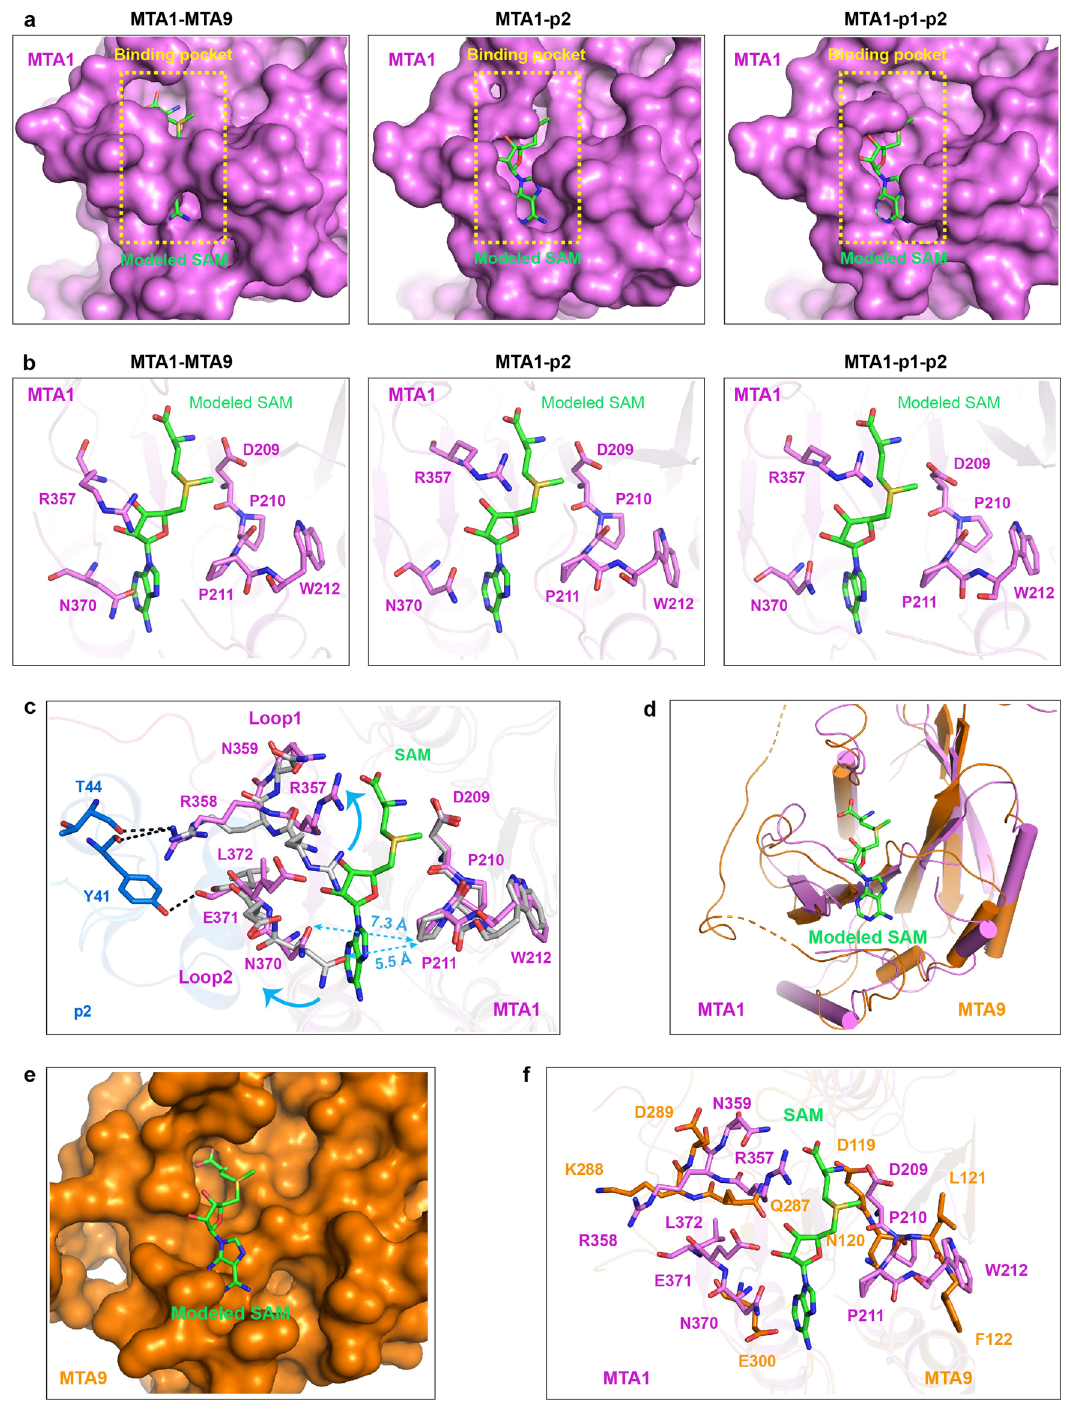
Fig. 6 Conformational change of MTA1 upon p2 binding. a Structural comparison of the SAM-binding pocket of MTA1 in the MTA1-MTA9 (left panel), MTA1-p2 (central panel) and MTA1-p1-p2 (right panel) complexes. Each MTA1 structure shows SAM-binding pocket in the SAM-free state. For comparison, a SAM molecule was modelled in the SAM-binding pocket of MTA1. b The SAM-binding pocket presents signi fi cantly different conformations in the structures of MTA1-MTA9 (left panel), MTA1-p2 (central panel) and MTA1-p1-p2 (right panel) complexes. Each MTA1 structure shows SAM- binding pocket in the SAM-free state. For comparison, a SAM molecule was modelled in the SAM-binding pocket of MTA1. c Superposition of the SAM- binding pocket within MTA1 in the MTA1-MTA9 complex (MTA1 in gray) with that in the SAM-bound MTA1-p2 (SAM in green, MTA1 in violet and p2 in marine) complex. d Structural comparison between MTA1 (violet) and MTA9 (orange). e MTA9 shows a potential SAM-binding pocket, a SAM molecule (green) was modelled in the potential SAM-binding pocket. f Superposition of the potential SAM-binding pocket of MTA9 (orange) with the SAM-binding pocket of MTA1 in the SAM-bound MTA1-p2 (SAM in green, MTA1 in violet) complex.